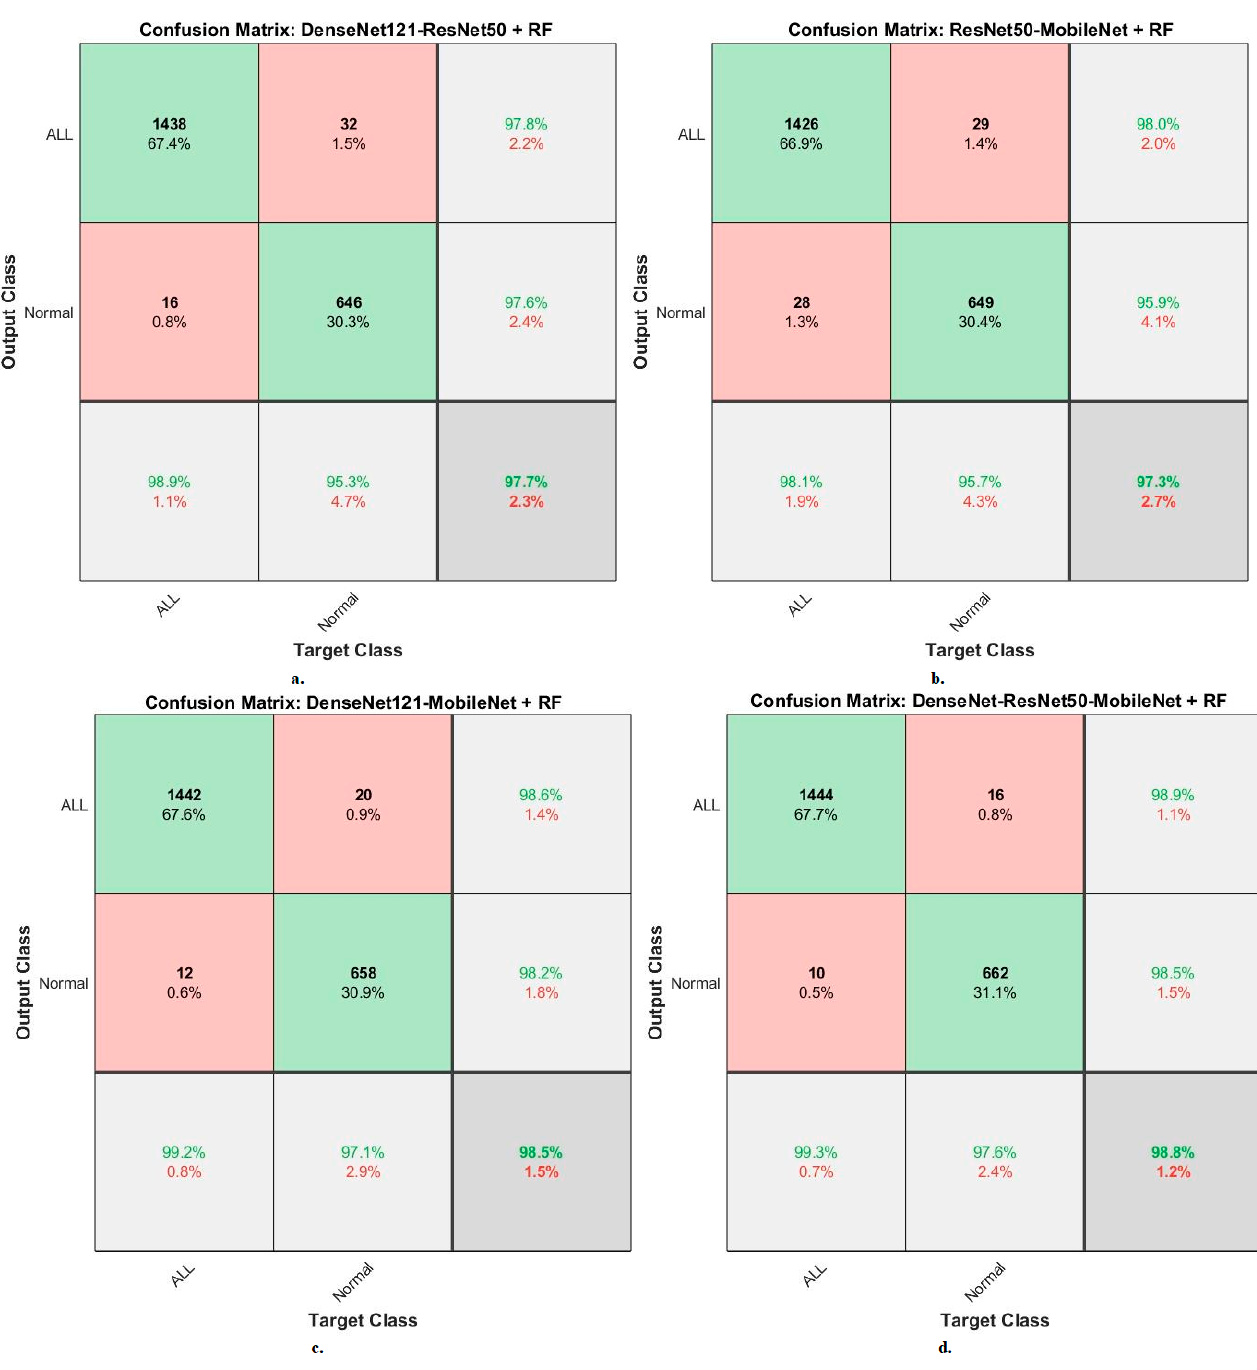
DenseNet121-ResNet50-MobileNet-XGBoost achieved an accuracy of 98.6% and 97.5% for